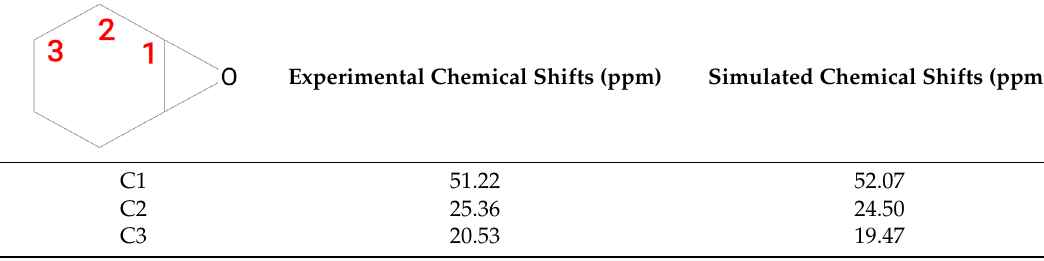
Figure 4. ( a ) Epoxidation reactions using niobium catalysts. Conditions: 25 °C; 60 min; molar ratio (2:1) H 2 O 2 /cyclohexene; 50 mg of catalyst. ( b ) ClNbS-AC catalyst reuse test at 25 °C, 60 min, 50 mg catalyst and H 2 O 2 /cyclohexene molar ratio 2:1.